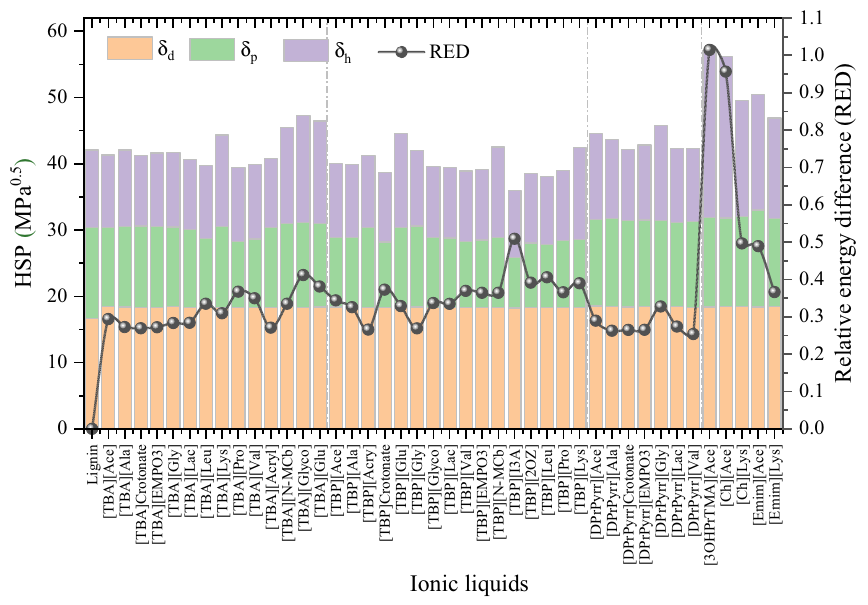
Figure 6. The COSMO-RS-based predicted Hansen Solubility Parameters of ionic liquids. COSMOquick tool version 1.7 is used to predict the HSP of ILs (https:// www. 3ds. com/ produ cts- servi ces/ biovia/ produ cts/ molec ular- model ing- simul ation/ solva tion- chemi stry/ biovia- cosmo quick/).